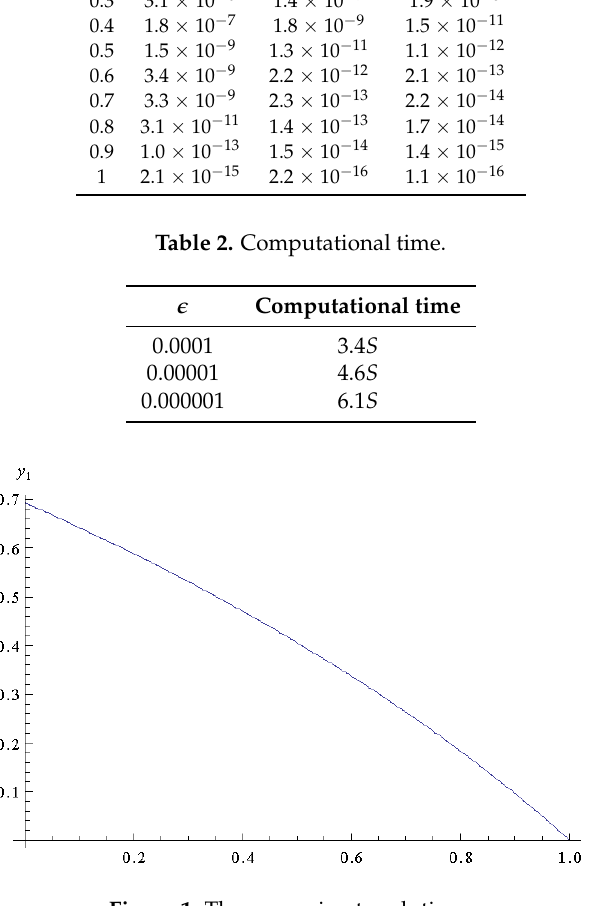
Figure 1. The approximate solution y 1